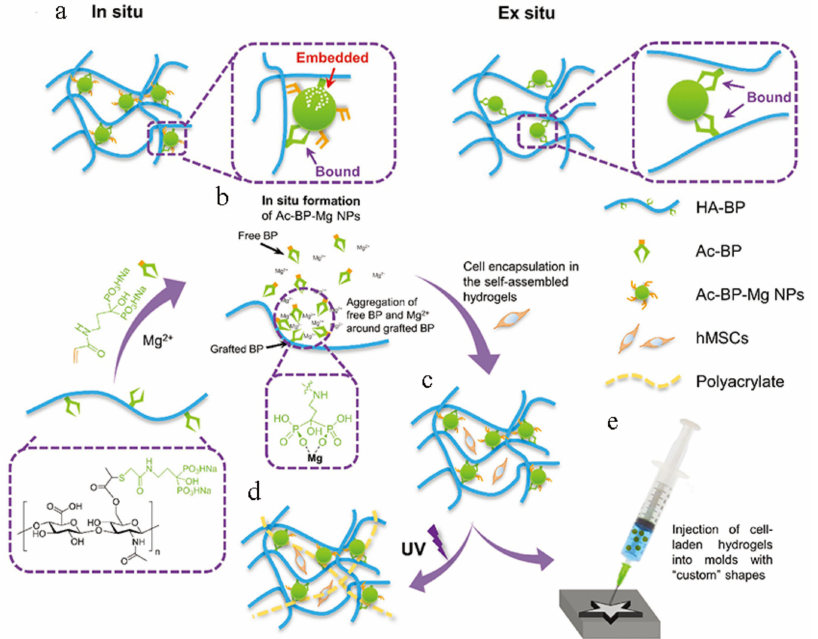
Figure 5. The in-situ formation of Ac-BP-Mg NPs enhances the mechanical properties of the HA-BP- Mg nanocomposite hydrogels. ( a ) In the in-situ hydrogels, some grafted bisphosphonates (BPs) of the HA-BP macromer are embedded into the in-situ-formed Ac-BP-Mg NPs (average particle size: 26.38 ± 6.46 nm), thereby strengthening the hydrogel network crosslinking, and the others are bound to the surface of NPs; for the ex situ hydrogels, mixing HA-BP with ex situ-formed MgSiO 3 NPs (average particle size: 22.85 ± 4.04 nm) only leads to formation of weak surface interaction between the grafted BPs and the ex situ nanoparticles (NPs). Schematic illustration of the fabrication of the self-assembled HA-BP-Mg nanocomposite hydrogels. ( b ) The in-situ self-assembly of Ac-BP-Mg NPs around the grafted BP groups of the HA-BP macromer via BP-Mg 2+ coordination. ( c ) The self-assembled cell- laden hydrogels are stabilized by the Ac-BP-Mg NPs. ( d ) UV-initiated radical polymerization of the acrylate groups at the surface of Ac-BP-Mg NPs leads to the secondary crosslinking and a further increase in the mechanical property of the self-assembled HA-BP-Mg nanocomposite hydrogels. ( e ) The cell-laden hydrogels can be injected and rapidly remolded to conform to the geometry of the injection sites